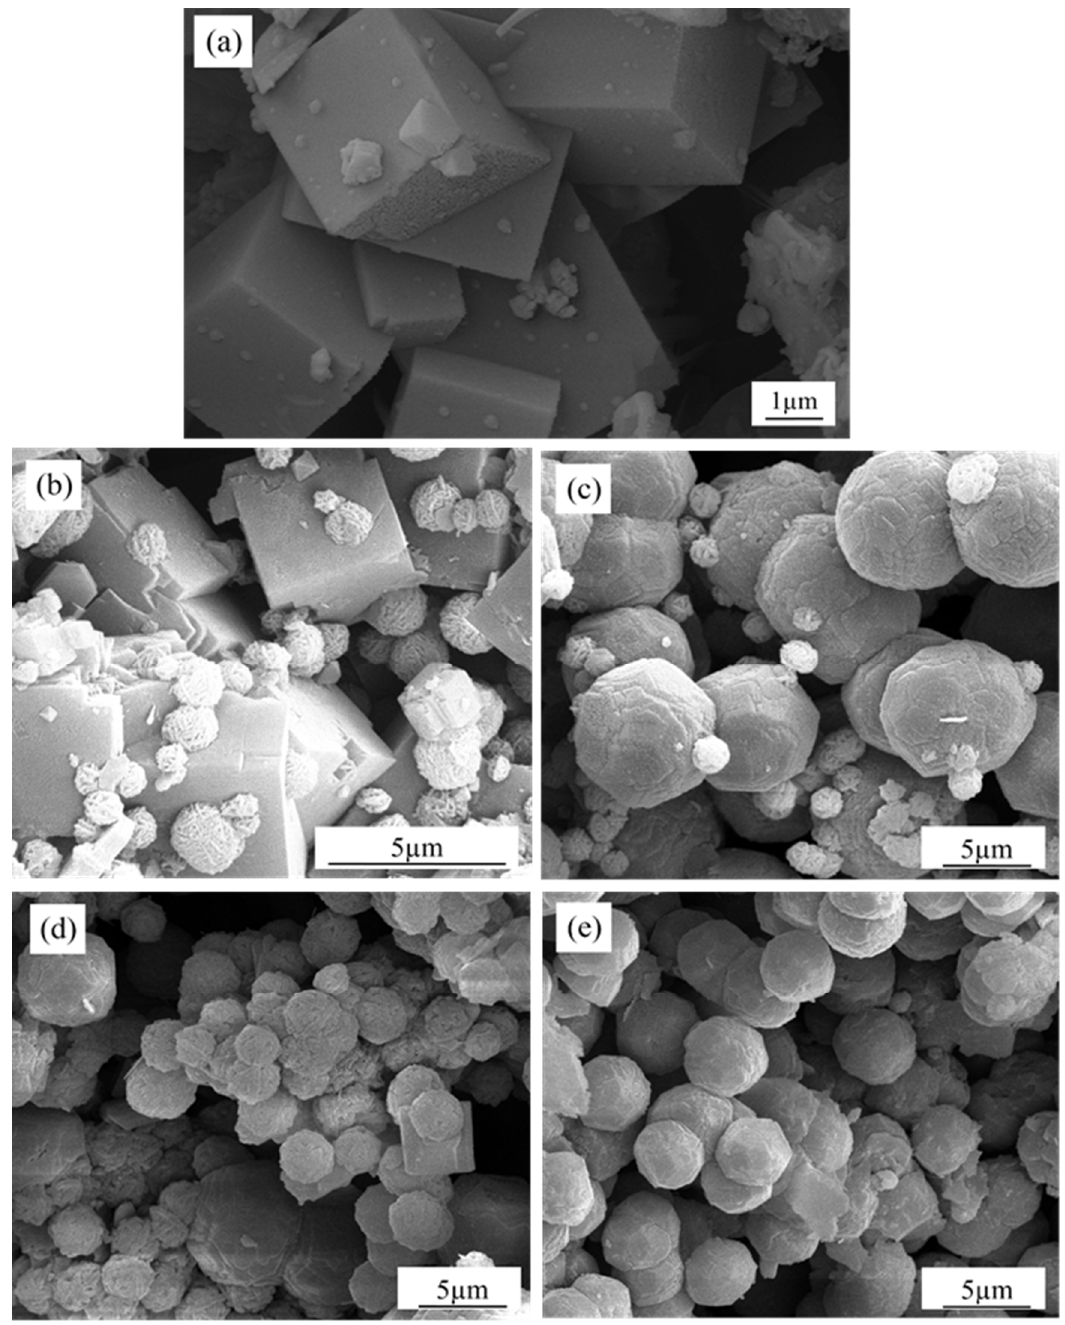
Figure 6. SEM images of specimens after hydrothermal treatment with various Si/Al molar ratios. ( a ) Si/Al = 1.0; ( b ) Si/Al = 1.25; ( c ) Si/Al = 1.50; ( d ) Si/Al = 1.75; ( e ) Si/Al = 2.0.